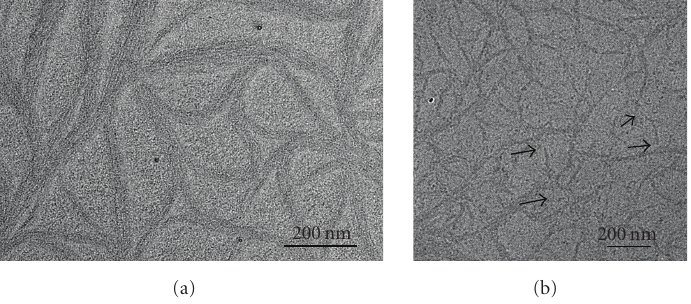
Figure 9: (a) TEM image of guanosine derivative 1 showing bundles of fibers. (b) Picture of compound 1 of individual fibers observed in a more dispersed area. The length of the fibers, which is close to 200nm, can only be measured on a very small number as they show a high tendency to fusion to form larger and entangled fibers.